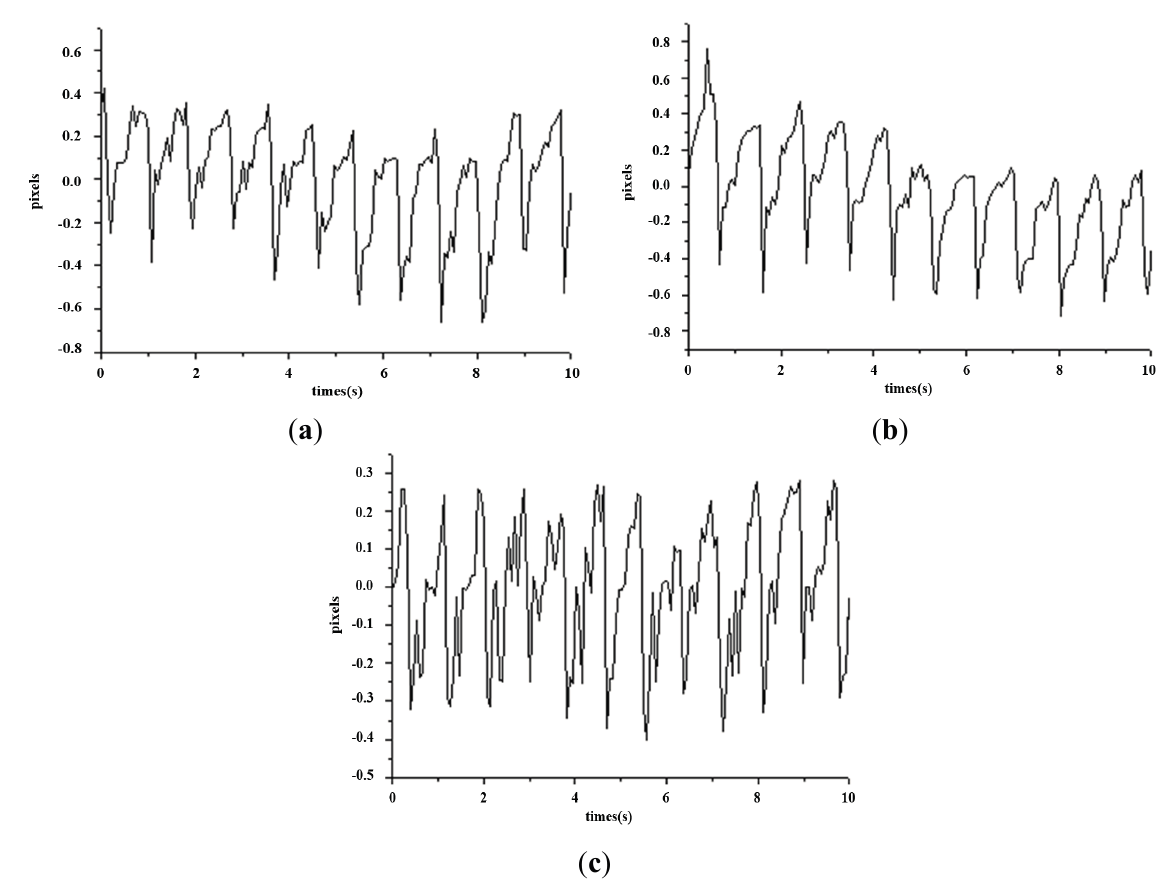
Figure 16. Waveforms for the cun, guan and chi pulses (time–amplitude). ( a ) Waveform for cun pulse (time–amplitude); ( b ) Waveform for guan pulse (time–amplitude); ( c ) Waveform for chi pulse